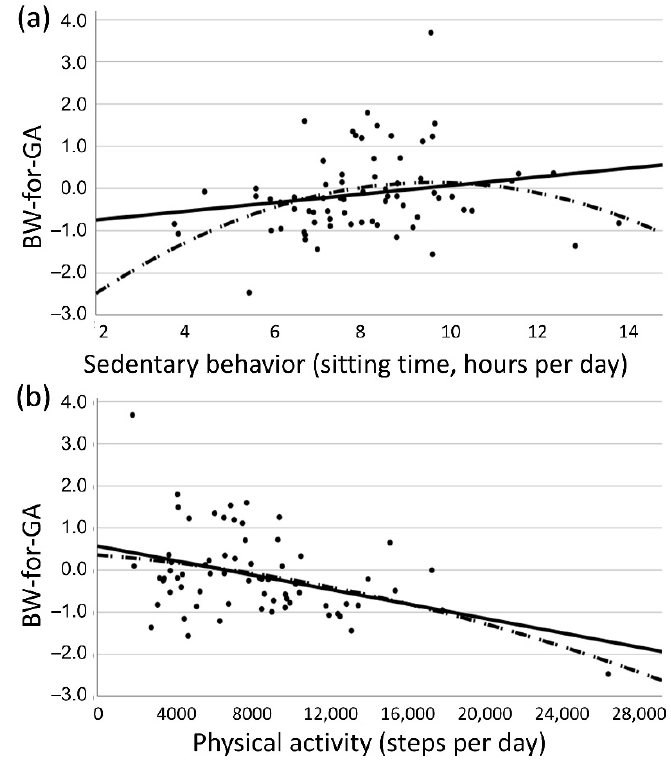
Figure 1. Mean sedentary behavior ( a ) and physical activity ( b ) at each evaluation period. Bars rep- resent 95% confidence intervals.